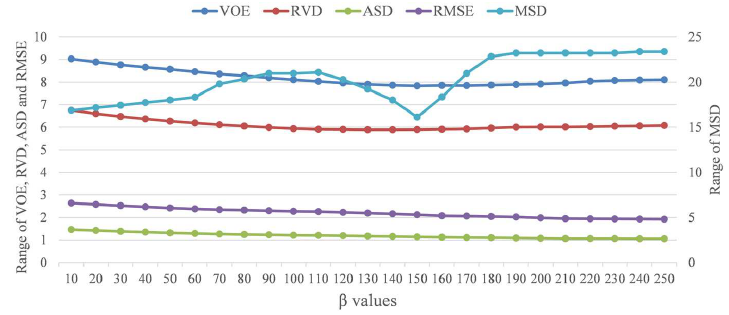
Fig 5. The ranges of VOE, RVD, MSD, ASD and RMSE with different parameter β .